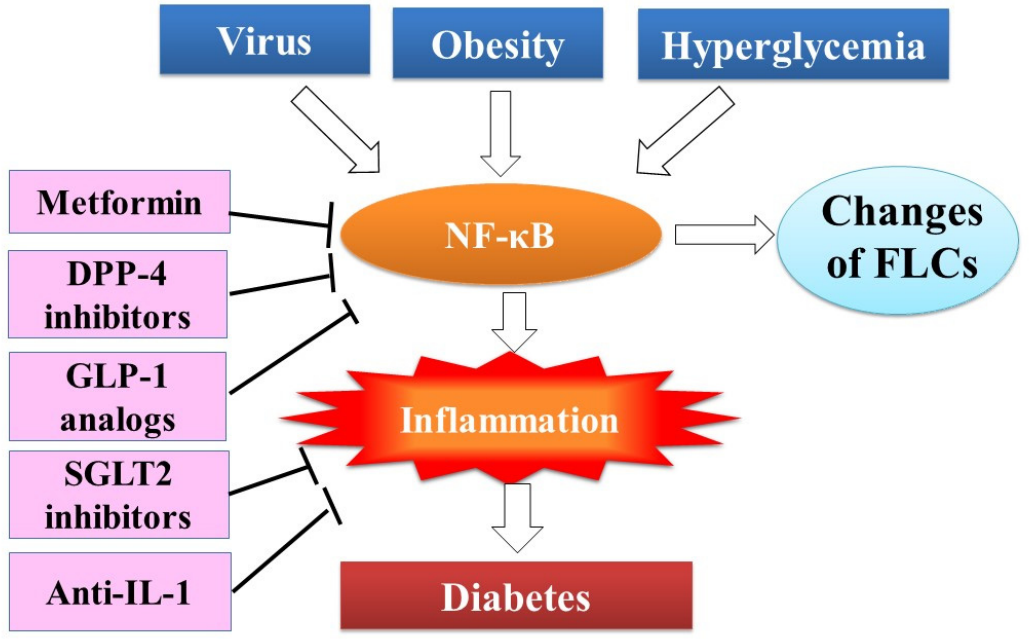
Figure 4. FLCs as inflammatory biomarkers of diabetes. Risk factors of diabetes such as viral infection, hyperglycemia and obesity activate nuclear factor kappa B (NF- κ B), which regulates transcription of immunoglobulin-free light chains in the immunoglobulin-producing B cells and plasma cells and production of many inflammatory molecules, leading to inflammation. Thus, FLCs were proposed to be biomarkers of NF- κ B activation and inflammation. Metformin, DPP-4 inhibitors and GLP-1 receptor agonists inhibit NF- κ B activation and inflammation, and SGLT2 inhibitors and anti-IL-1 therapy inhibit inflammation.